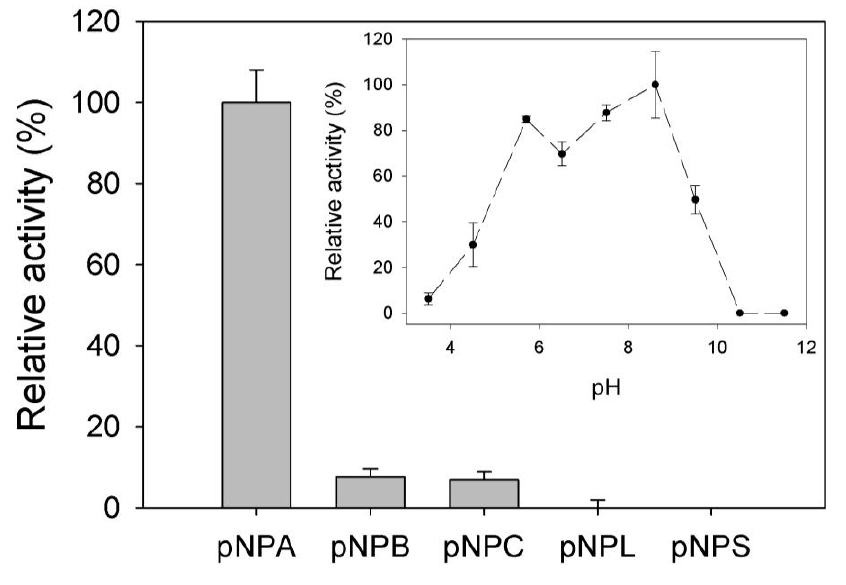
Figure 3. MHlip substrate specificity measured at pH 8 and influence of the pH on the MHlip activity (the